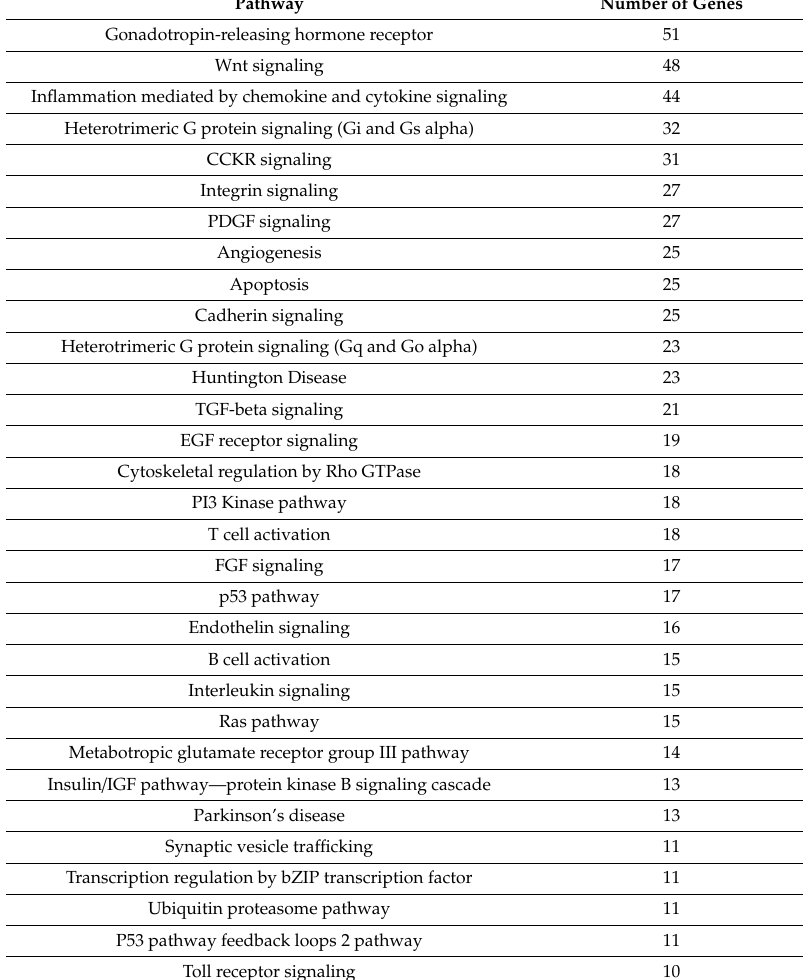
Table 1. Predicted gene targets of miR-518f-5p are involved in many cancer-associated pathways.